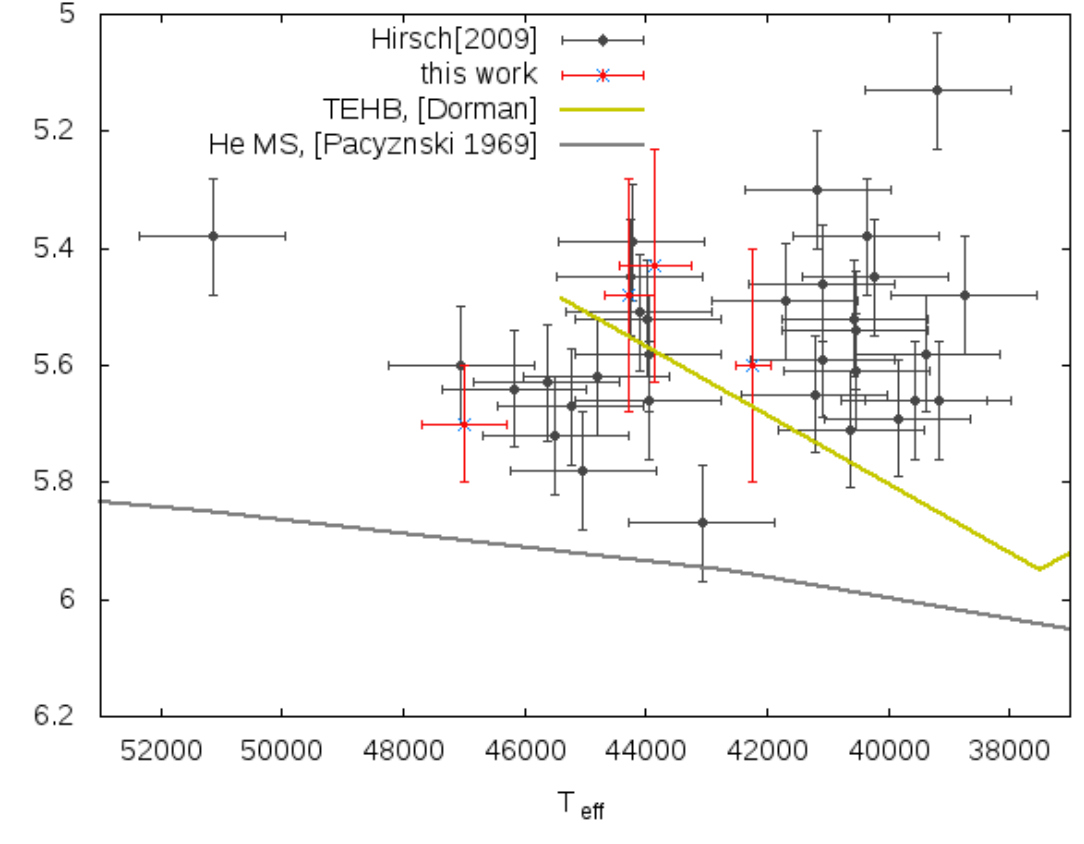
Figure 4. T eff /log(g) diagram of sample stars in comparison with He-sdOs from Hirsch[2009]. In addition, tracks for the He-Main Sequence and the Termina Age Extreme Horizontal Branch are shwon.